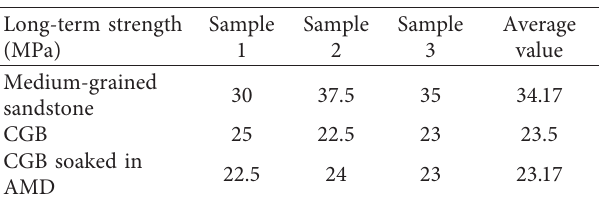
Table 12: Creep parameters of medium-grained sandstone, CGB, and CGB soaked in